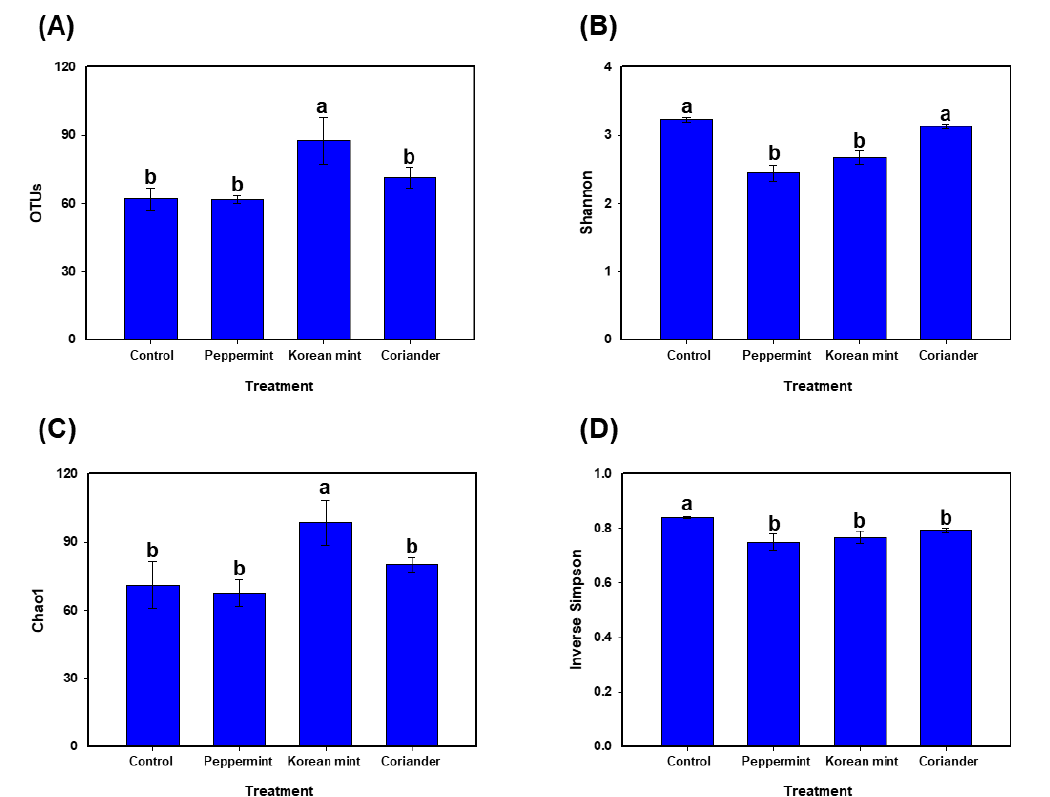
Figure 2. Alpha diversity in the soy paste samples prepared by adding Peppermint, Korean mint, and Coriander, relative to that in control. ( A ) Number of operational taxonomic units (OTUs), ( B ) Shannon diversity index, ( C ) Chao1 richness index, and ( D ) Inverse Simpson’s index. Data are represented as the means ± standard deviations in triplicate. Different letters on the error bars represent significant differences at p < 0.05.